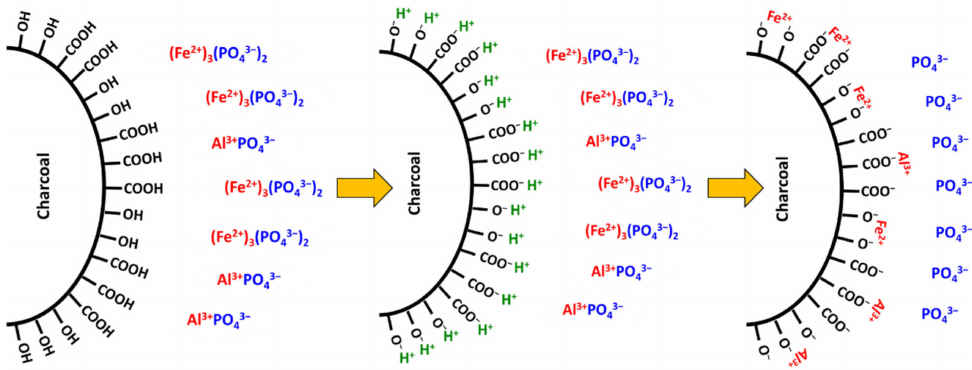
Figure 7. Proposed mechanism of the aluminium and iron chelation reaction at the negatively charged exchange sites of charcoal (adapted from Palanivell